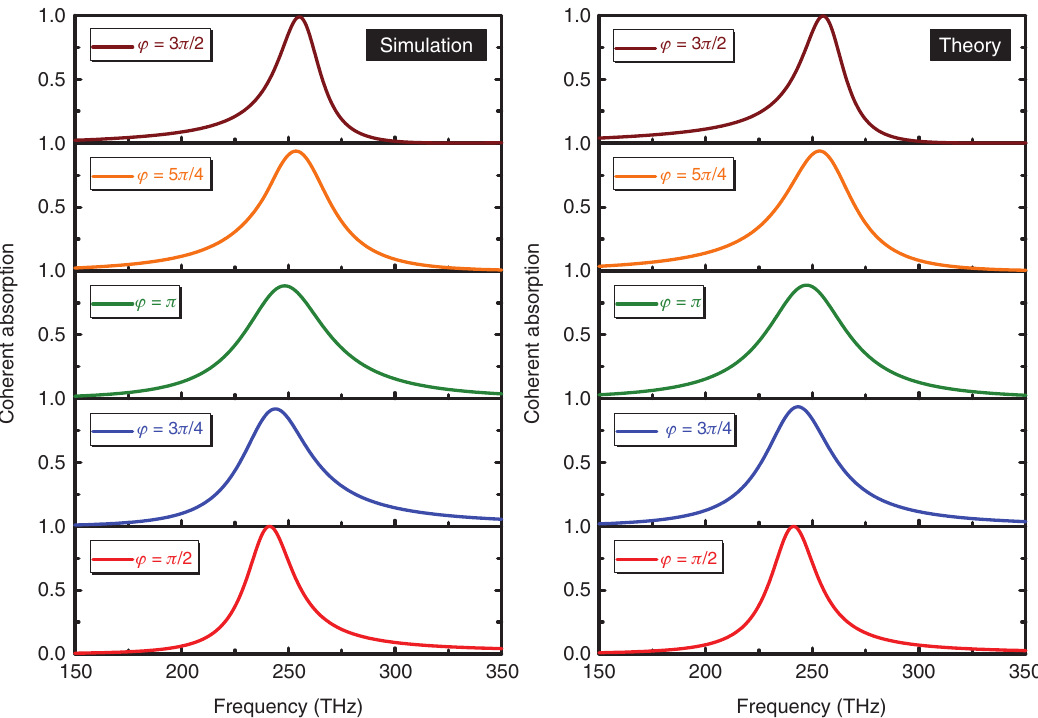
Figure 4: The spectrum of PC-CA of the designed optical system possessing the phase coupling as a function of the phase coupling ϕ for antisymmetric incidence. The left and right columns respectively show simulation and theoretical results.